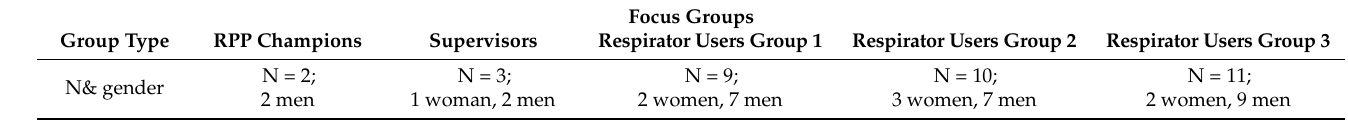
Table 1. Focus group